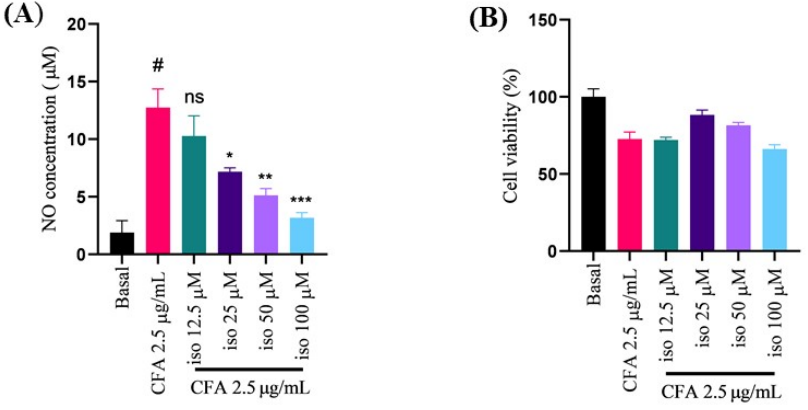
Figure 1. Effect of isoleucilactucin on coal fly ash (CFA)-induced nitric oxide (NO) generation and viability in MH-S cells. ( A ) Cells were categorized into six groups: basal (control), CFA (2.5 µ g/mL), and four concentrations of CFA with isoleucilactucin (12.5, 25, 50, and 100 µ M). Cells were treated with the different isoleucilactucin concentrations for 30 min before CFA treatment and incubated for 18 h. The Griess reagent method was used to determine the NO level. ( B ) The MTT reagent method was used to perform a cell viability experiment. A 24-well plate was used to seed the cells. Values from three independent experiments were expressed as the mean ± SEM ( n = 3). Compared with the basal group, ns: not significant, # p < 0.001; compared with the CFA group, * p < 0.05, ** p < 0.01, and *** p <